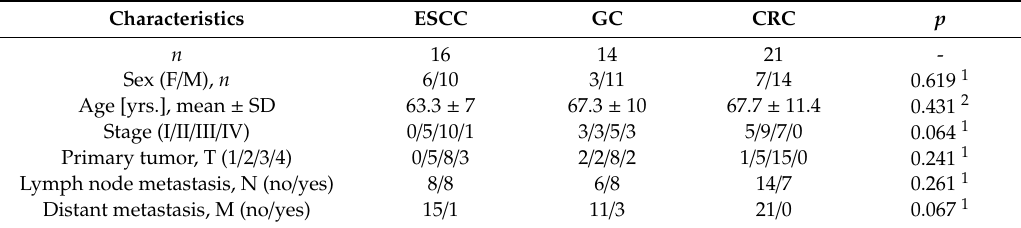
Table 1. Characteristics of study population for analysis of local interleukin expression at mRNA level.